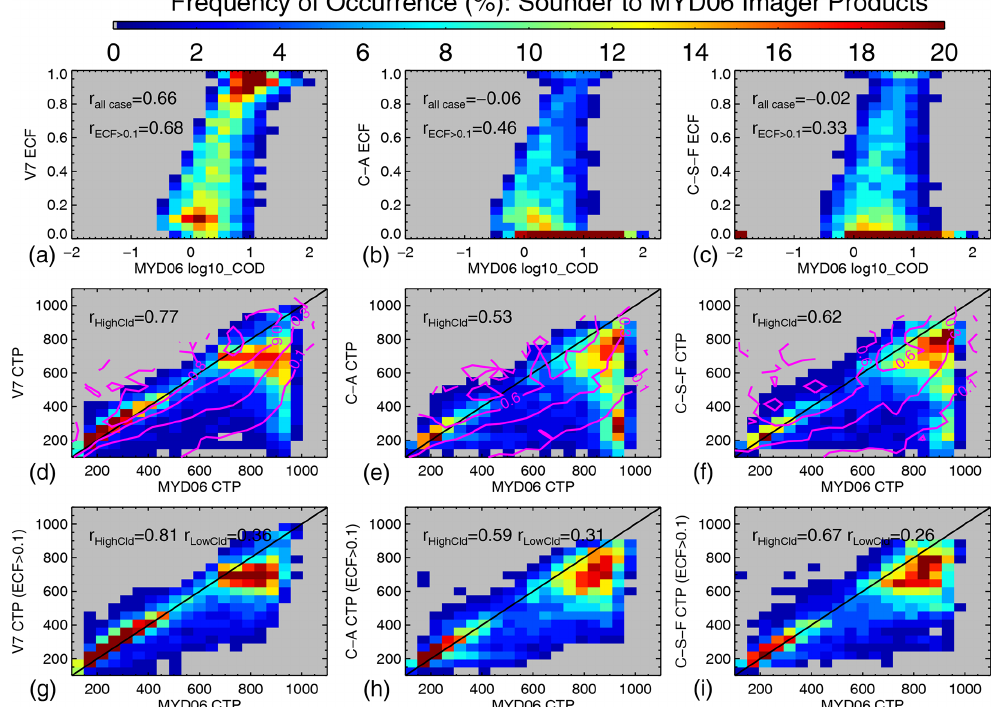
Figure 5. Comparisons of sounder- and imager-derived cloud properties shown by joint distribution of case frequency of occurrence. Pan- els (a) , (b) , and (c) show the evaluation of sounder-derived ECF by cloud optical depth (COD, on a log 10 scale) from the MYD06 products. Panels (d) , (e) , and (f) compare the sounder effective CTP with CTP from MYD06 overlaid by the magenta contours showing the mean ECF from the corresponding sounder retrievals. Panels (g) , (h) , and (i) are similar to panels (d) , (e) , and (f) except that the cases with sounder ECF < 0 . 1 are removed from the comparison. Different sounder retrieval algorithms are included. From left to right, data from AIRS ver- sion 7, CLIMCAPS-Aqua (C-A), and CLIMCAPS-SNPP FSR (C-S-F) are used. The data points located in regions poleward of 60 ◦ are excluded. Cases are included only when both retrievals in comparison ( x and y axes of the plot) report valid retrievals. The cloud properties from MODIS pixels collocated within the same sounder FOV are averaged before comparison with the IR sounder data. Linear correlation coefficients between the variables on the x and y axes for different conditions are given in each